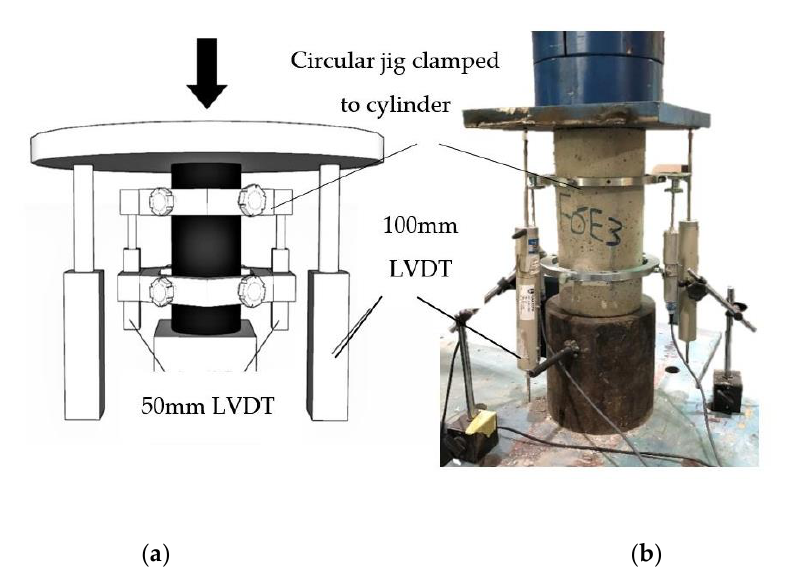
Figure 1. The uniaxial compression test: ( a ) conceptual, ( b ) actual.